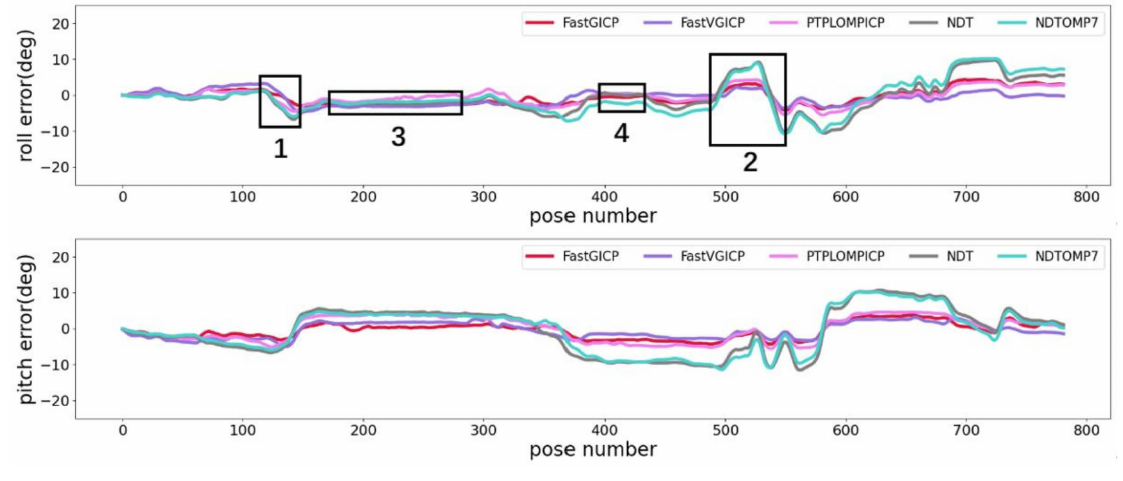
Figure 7. Roll and pitch errors of registration algorithm.